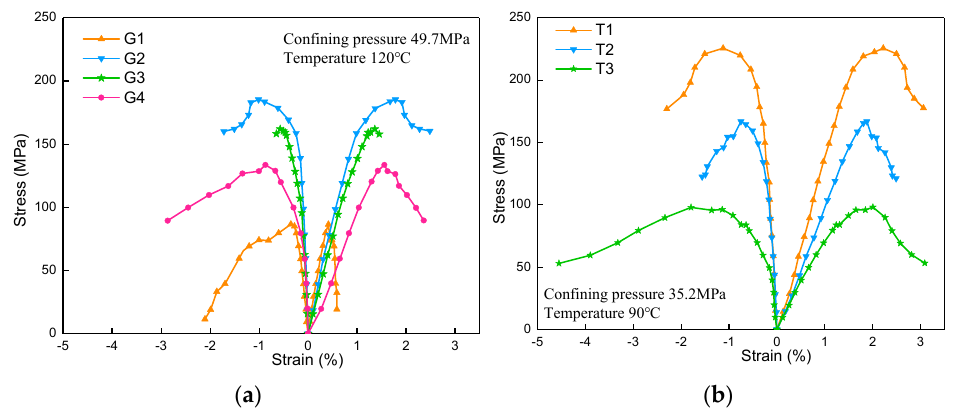
Figure 13. Stress − strain curves of caprock samples: ( a ) Well Gu15; ( b ) Well T29. Table 13 shows the laboratory test results of caprock. Under normal temperature and low confining pressure, the hard rock generally fails in brittle mode. When the stress reaches its peak value, the magnitude of the strain is generally 10 − 3 . In this test, except for G1 (strain magnitude of 10 − 3 , elasticity index of 64.68%, plasticity index of 1.57%), all failure modes of the other rocks were a ductile failure. Under the simulated formation conditions, the strain magnitude is 10 − 2 , in which the axial compression strain is 1.36–3.2%, the elastic index is 33.38–58.19%, and the average value is 47.56%. The plasticity index ranges from 19.98 to 67.98%, with an average value of 47.60%. Therefore, caprock is believed to have a certain plastic deformation capacity. Table 13. Rock mechanics test results of caprock samples under formation